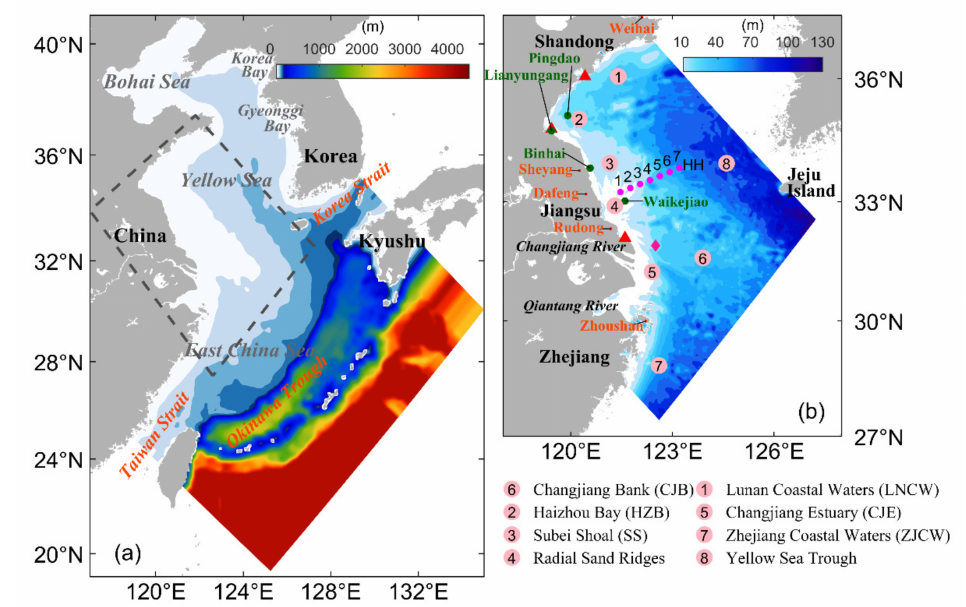
Figure 1. Major bathymetric features over domains of ( a ) the outer model for the China Seas and adjacent deep ocean waters of the northwestern Pacific and ( b ) the inner model for the swYS and adjacent shelf waters of the nested-grid ocean circulation modelling system (NGMS-swYS). Red triangles in ( b ) indicate positions of three in situ observation stations: Xiaomaidao (XMD), Lianyungang (LYG) and Lvsi (LVS). Dark green dots indicate positions of four coastal tidal stations: Pingdao, Lianyungang, Sheyang and Waikejiao. The red diamond indicates the in situ current observation station (DD). Pink dots represent seven observation stations along transect HH conducted by Hohai